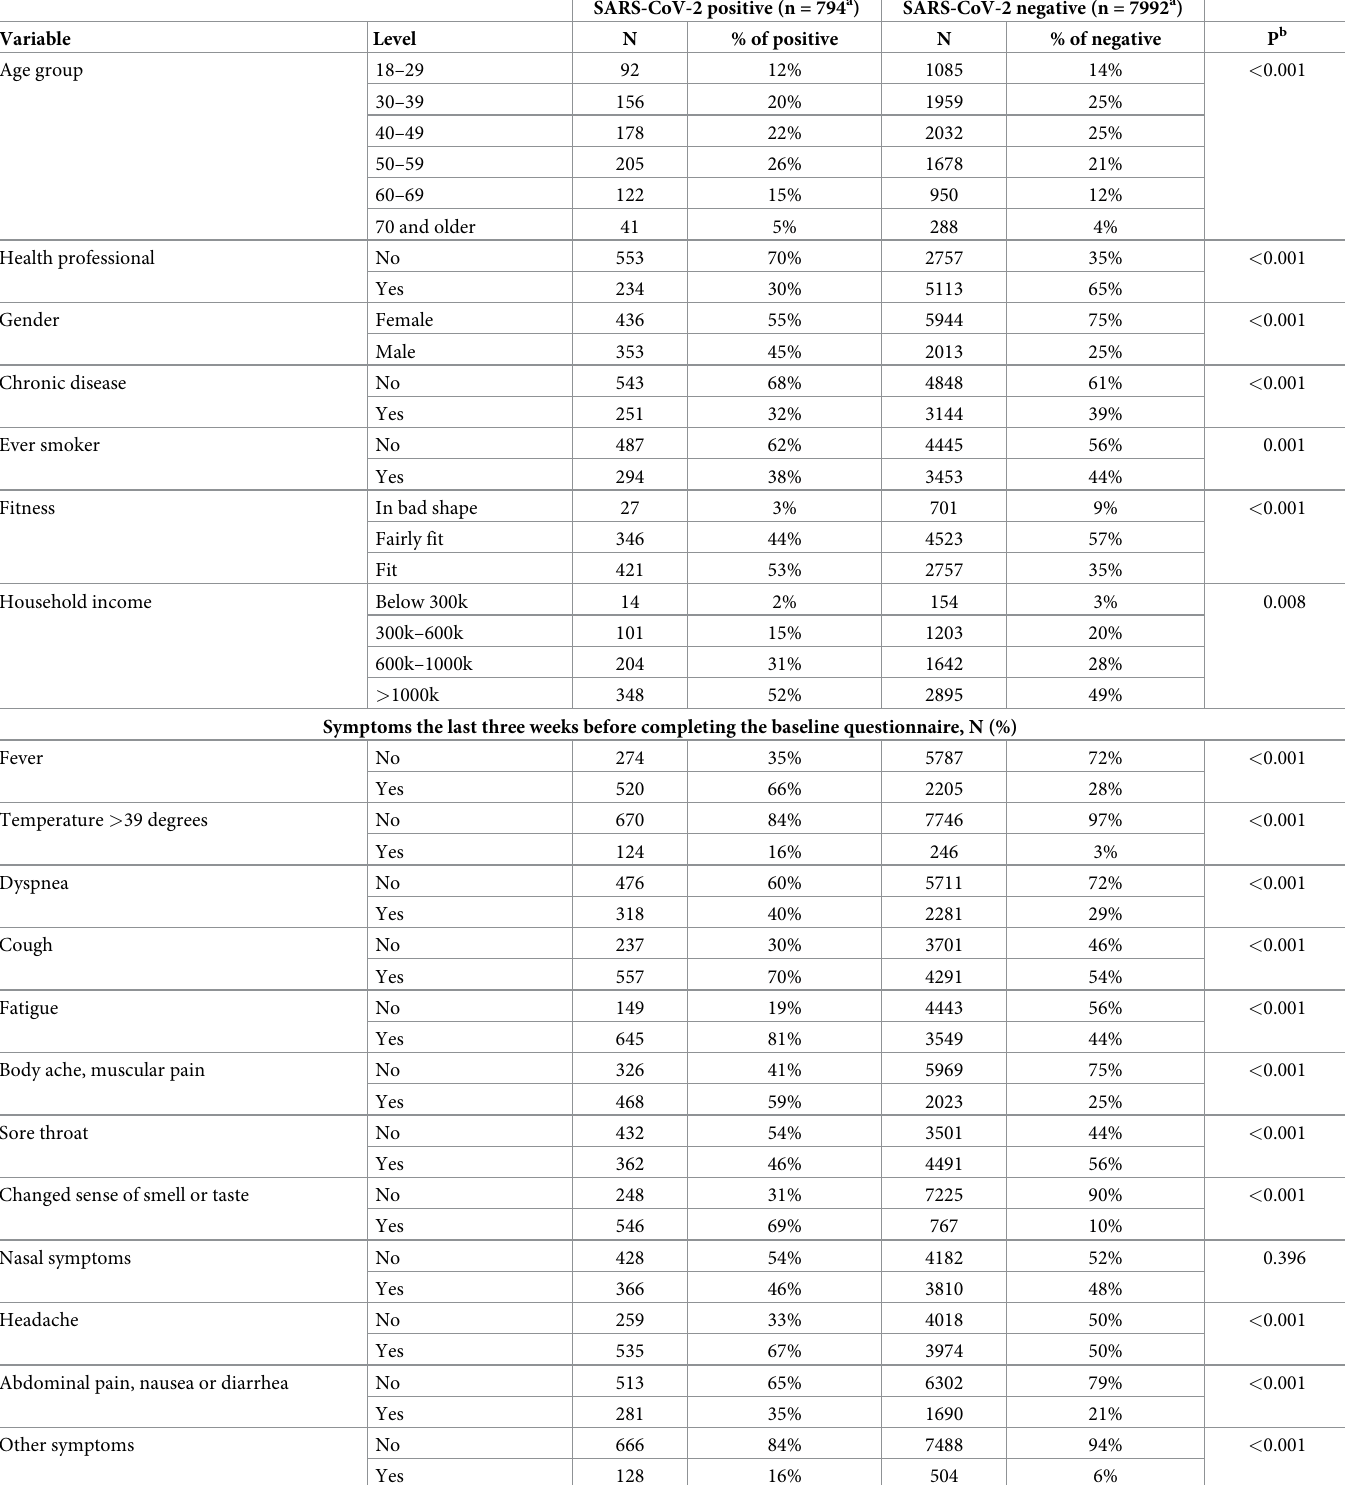
Table 2. Study population and baseline